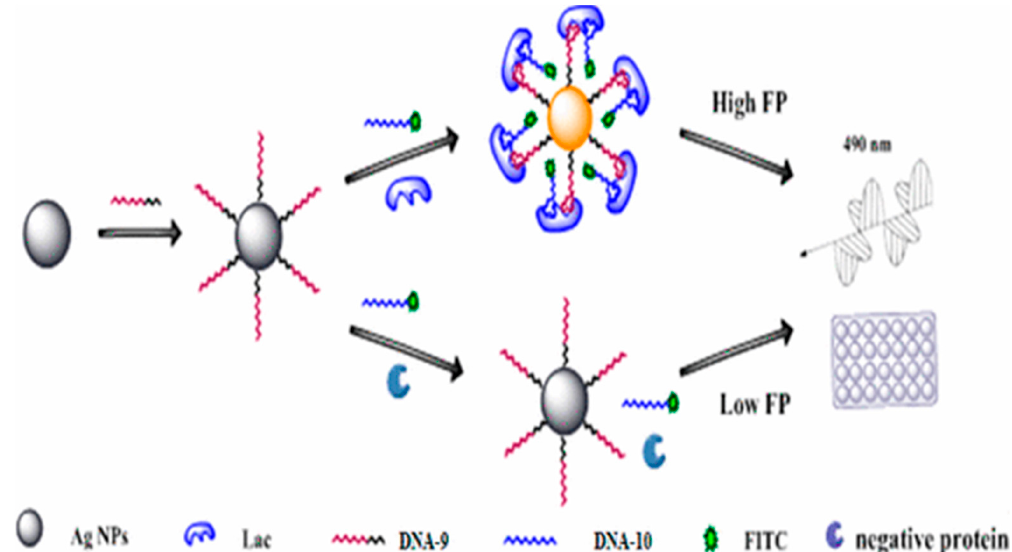
Figure 5. Scheme of bivalent aptasensor for detecting lactoferrin by using fluorescence polarization (reprinted with permission) [115].